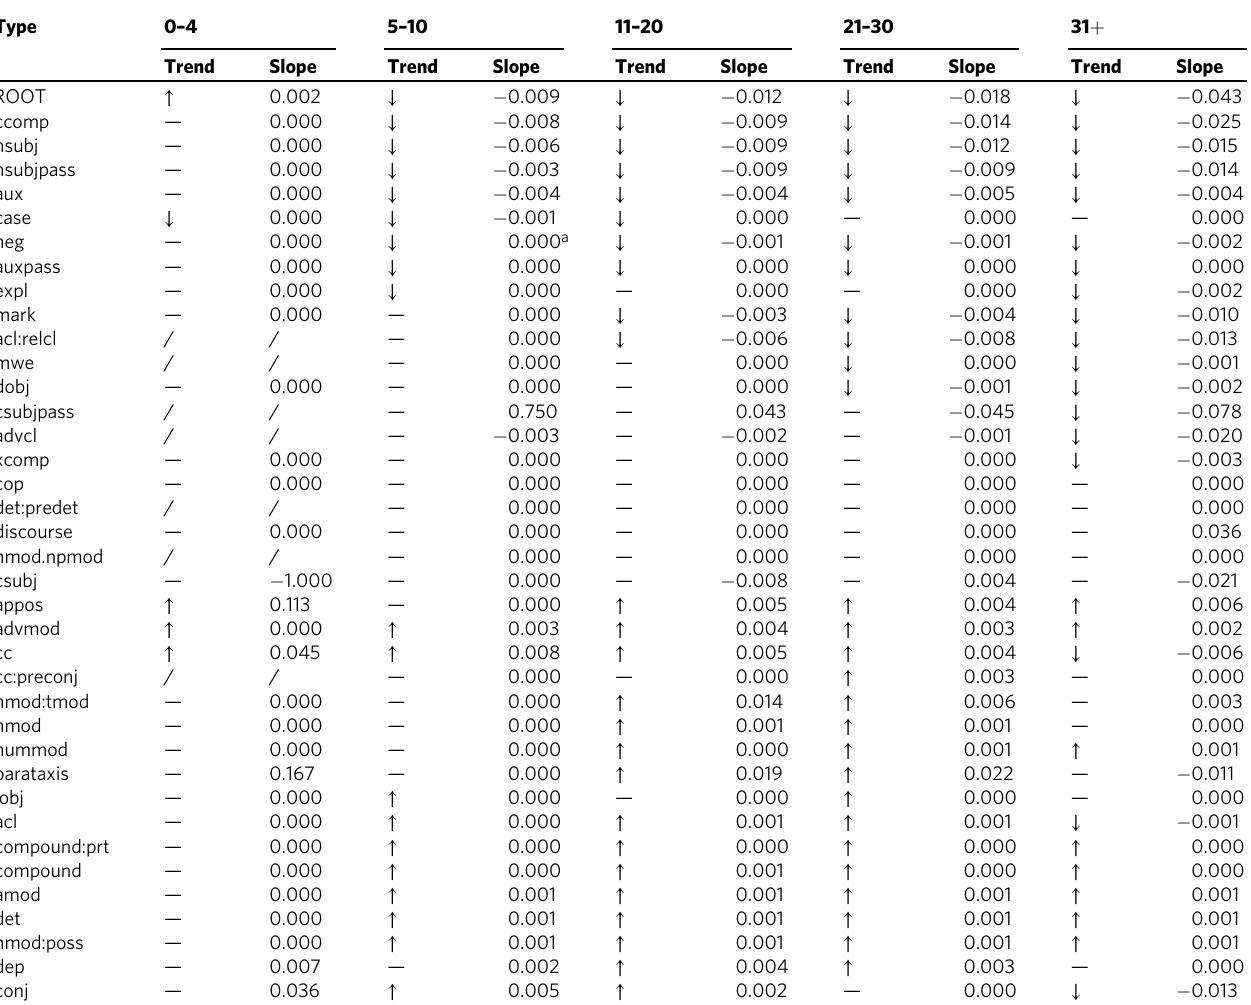
Table 3 Mann-Kendall trend tests results on MDDs of different dependency relations.